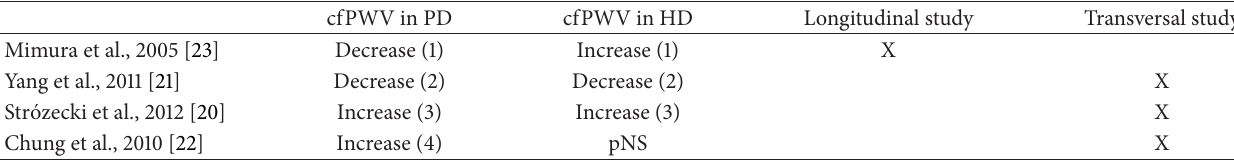
Table 3: Arterial (aortic) stiffness and modality of dialysis.